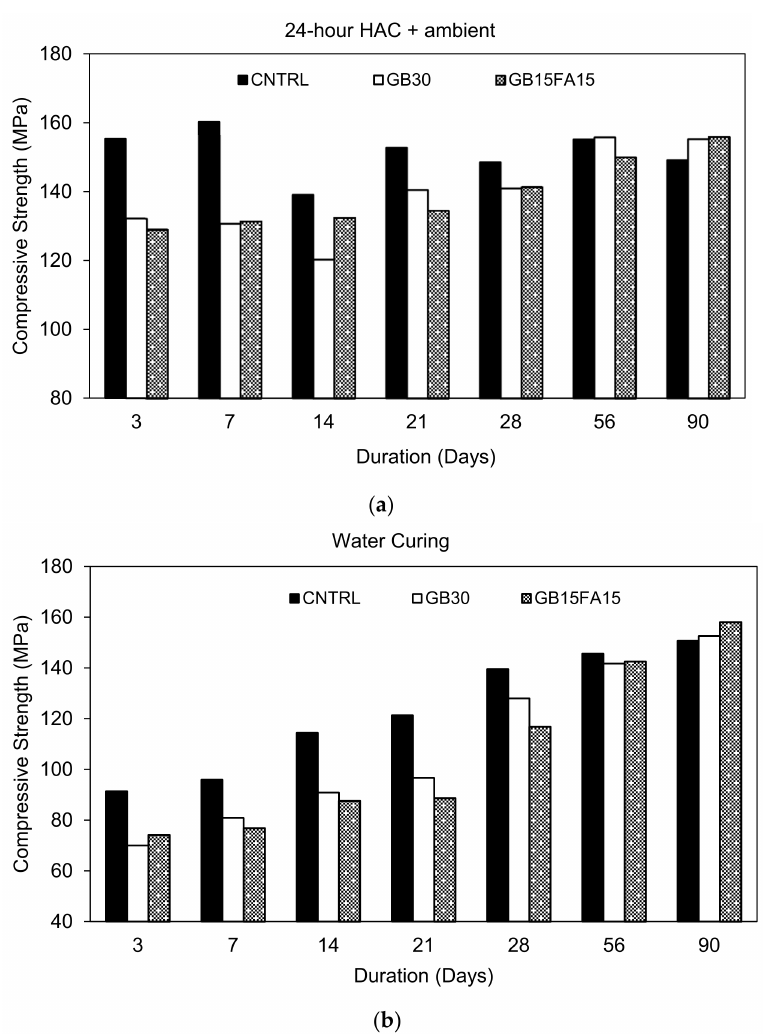
Figure 5. Compressive strength development. ( a ) HAC + ambient; ( b ) water